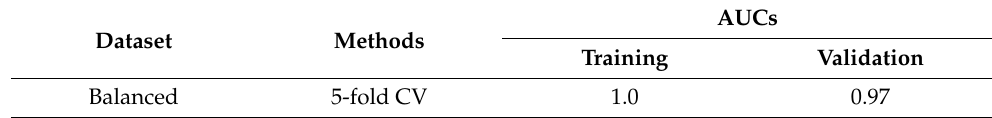
Table A1. Performance of RF-SHAP